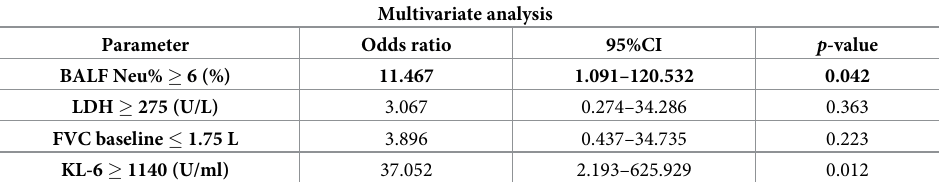
Table 5. Predictive markers of death within 3 years in the PF-ILD group, based on multivariate logistic regression